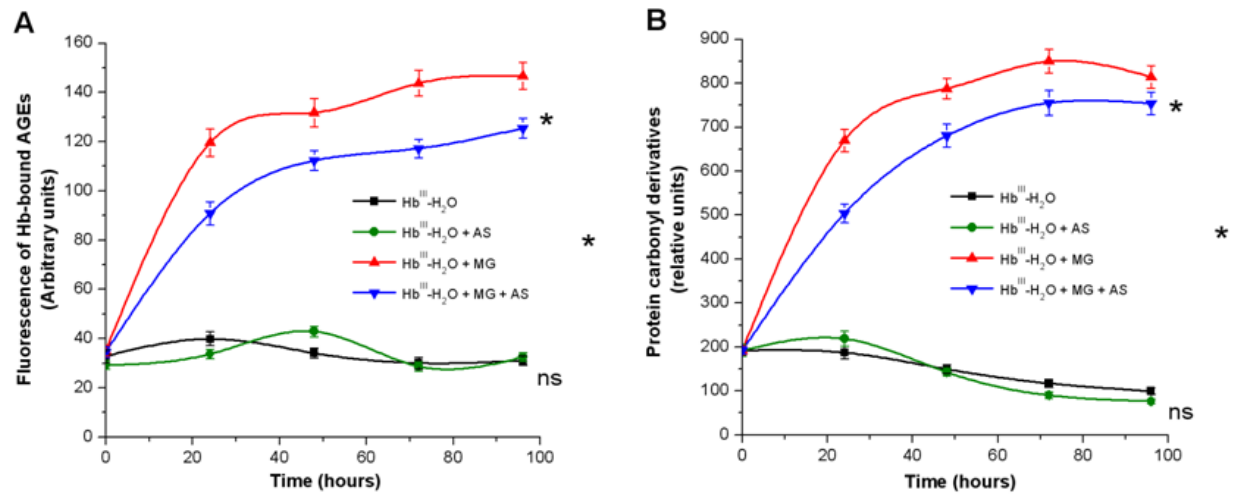
Figure 4. The effect of Angeli’s salt on formation of fluorescent AGEs ( A ) and carbonyl groups ( B ) in metHb-H 2 O reaction with MG. Reaction mixture: 0.15 mM metHb-H 2 O in 50 mM PBS (pH 7.4), 54 mM MG, 3.2 mM Angeli’s salt. Results are depicted as the mean with S.E.M. of three independent experiments ( n = 3). Two-way ANOVA ( A , B ) (* p ≤ 0.05; ns: non-significant).